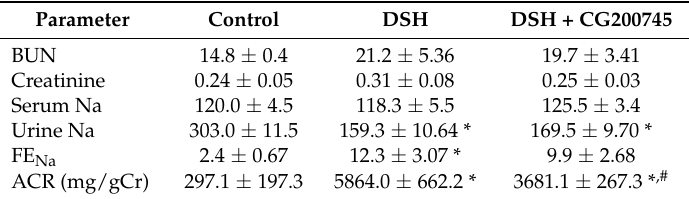
Table 2. Changes in renal function among experimental groups of